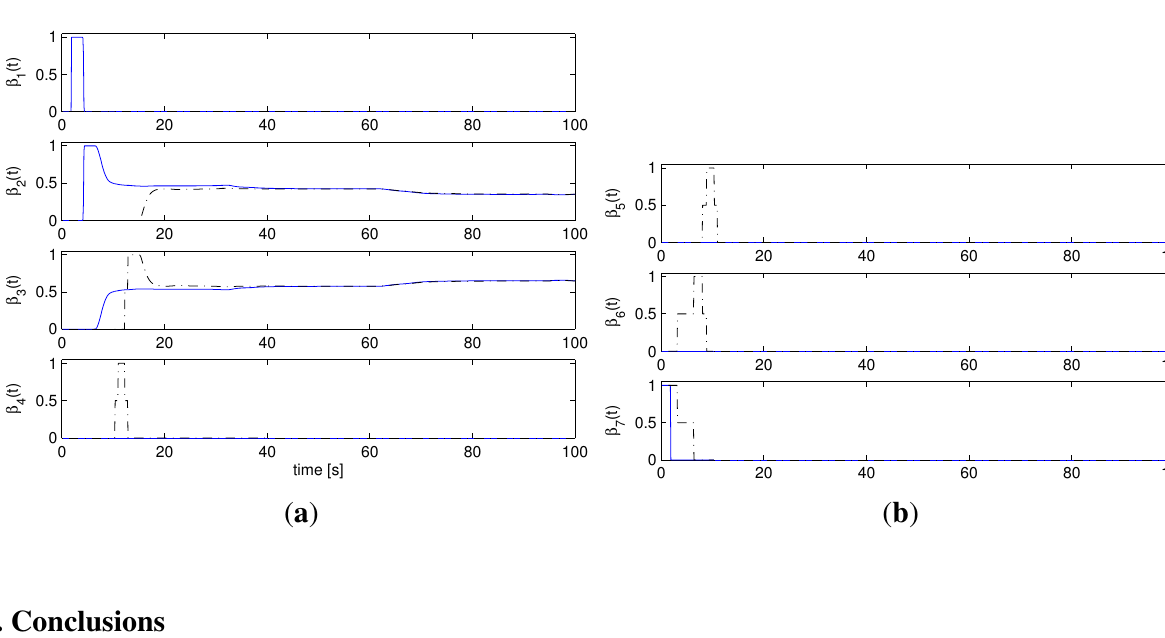
Figure 9. Unmodeled dynamics, θ ∗ = 0 . 18 : AMC controller weights β ( t ) : Multi-AMC (solid), AMC (dash-dotted). ( a ) β